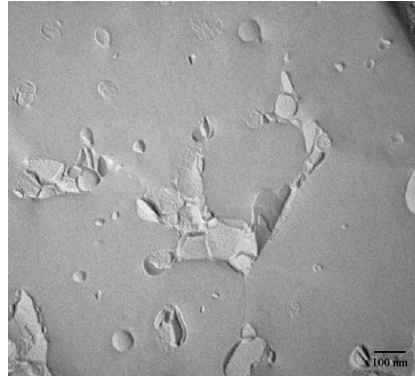
Figure 1. Typical freeze-fracture transmission electron microscopy (FF-TEM) micrographs of ubidecarenone-loaded nanostructured lipid carrier (UB-NLC).